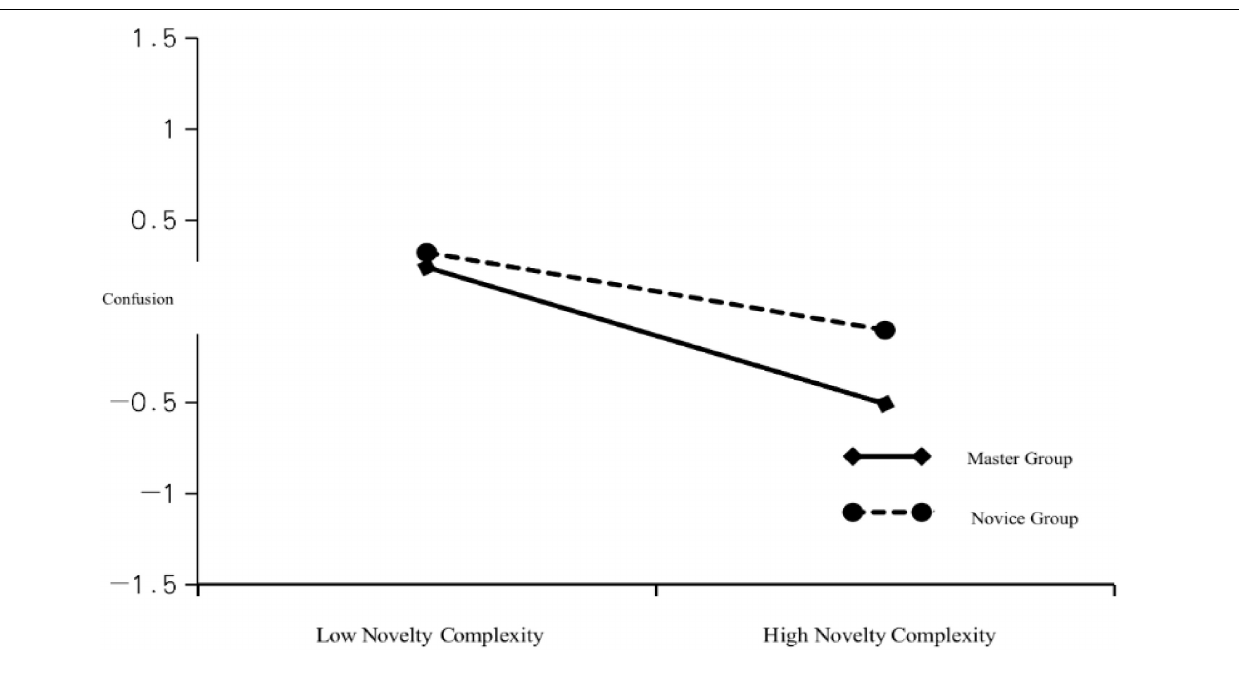
FIGURE 4 | Adjustment chart of grouping for novelty–complexity and confusion.